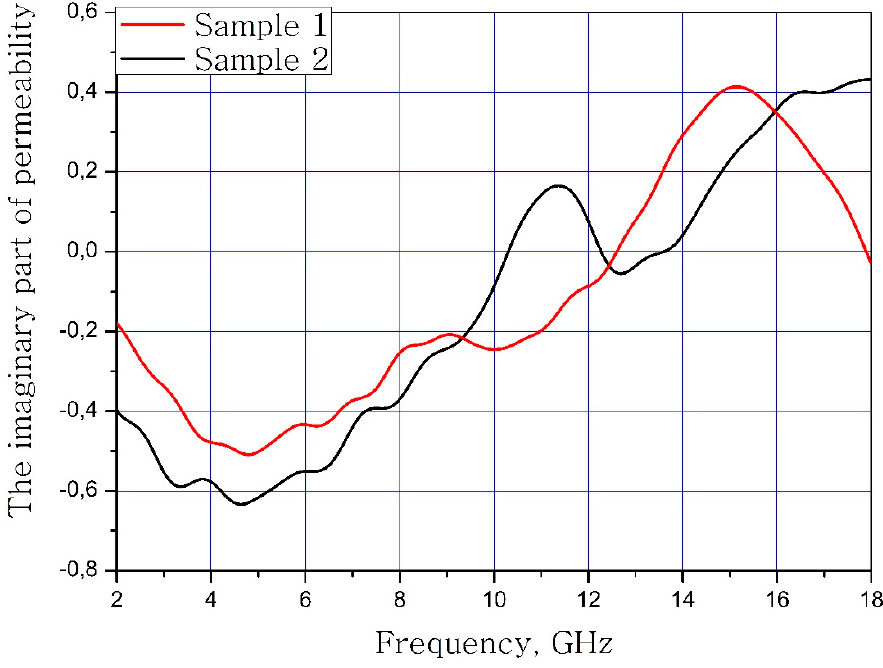
Nanomaterials 2019 , 9 , x FOR PEER REVIEW Figure 5. Frequency dependence of the real part of the magnetic permeability of the samples.